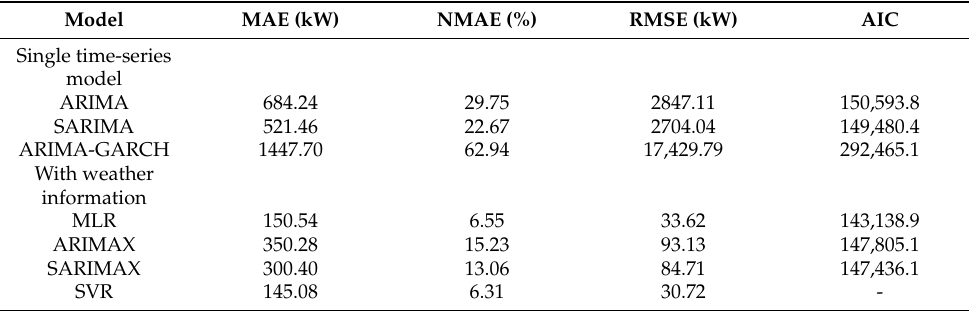
Table 3. Comparison of performance of each model excluding artificial control